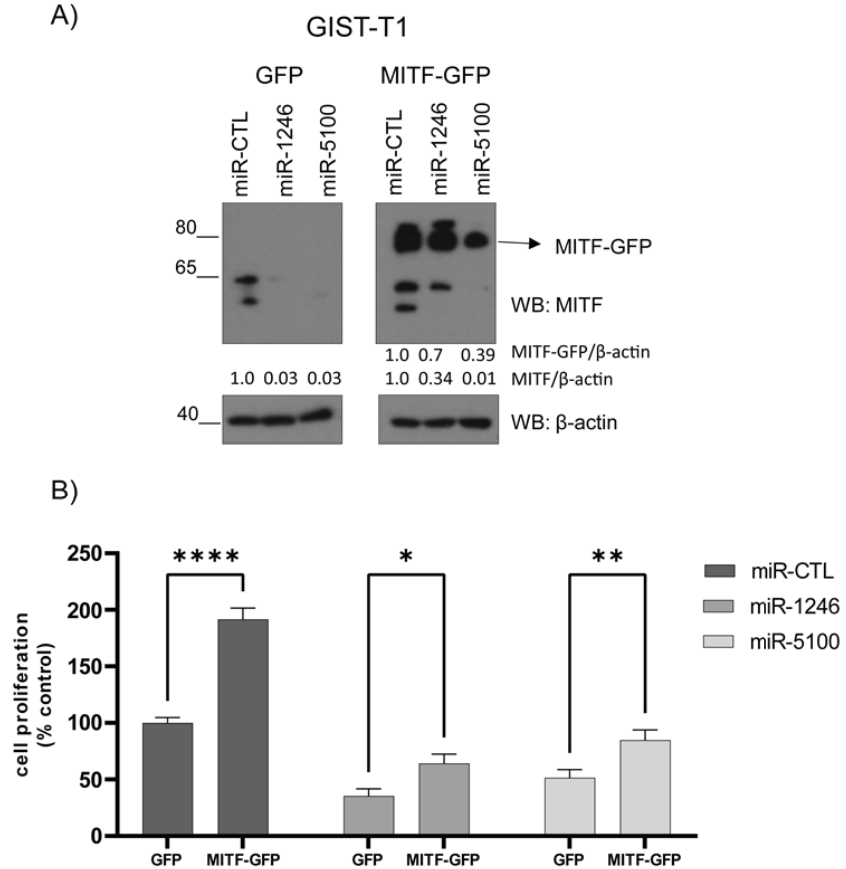
Figure 7. Overexpression of MITF reverses the phenotype produced by miRNAs in GIST-T1. Cells were transiently transduced with GFP or MITF-GFP plasmids on the 3rd day after lentiviral miRNA transduction. ( A ) Western blot shows MITF-GFP and MITF (endogenous) levels in GFP or MITF-GFP overexpressed cells. β -actin was used as a control. ( B ) Cell proliferation was measured by WST-1 on the 7th day after lentiviral miRNAs transduction. (* p < 0.05, ** p < 0.01, **** p < 0.0001. One-way ANOVA with Bonferroni ’ s post-hoc test) n = 3 .